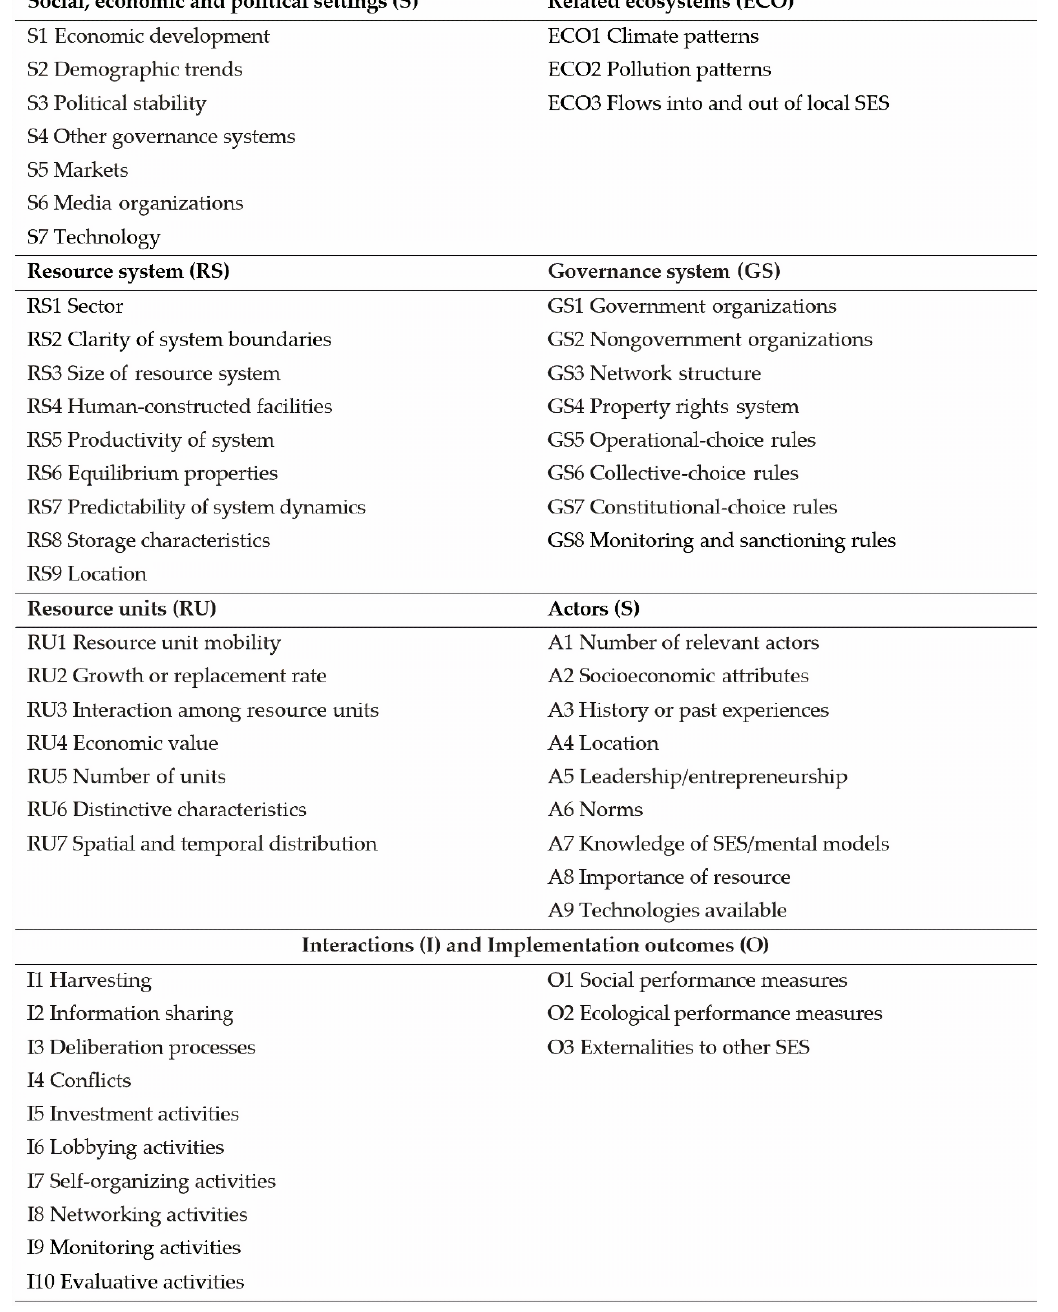
Figure 1. First and second tier of the socio-ecological system (SES) framework. Source: McGinnis and Ostrom [10].